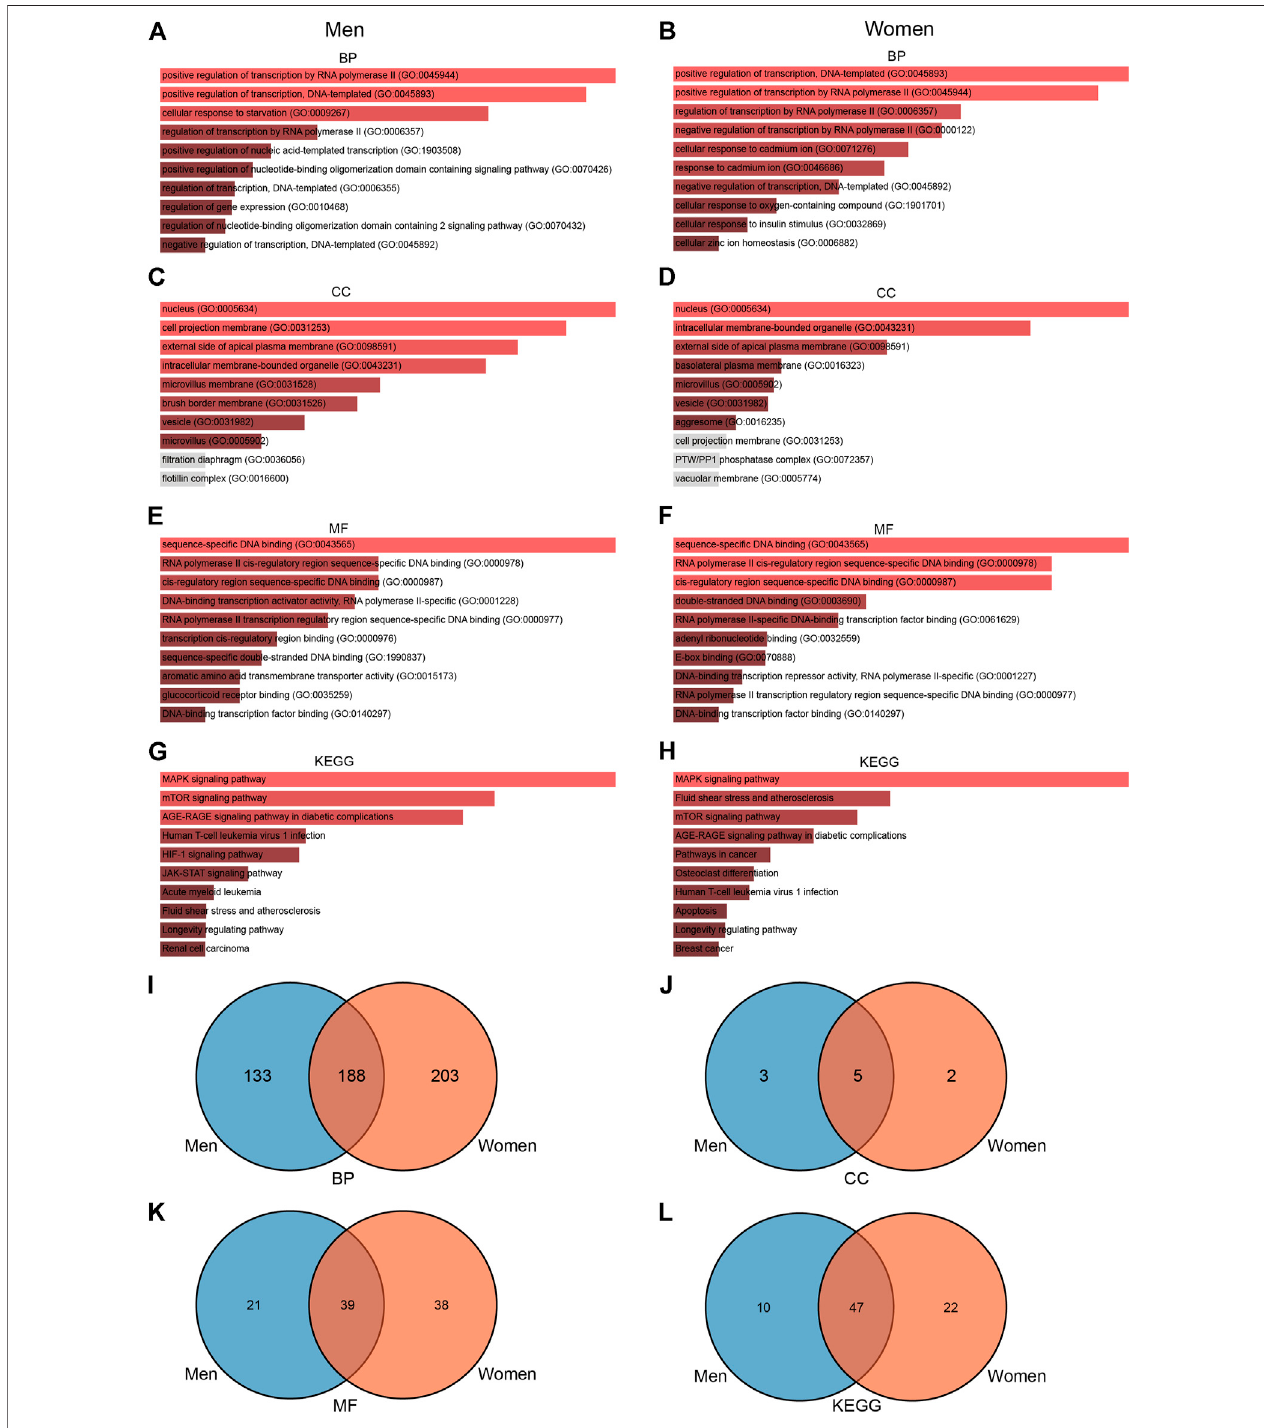
FIGURE 4 | GO and KEGG enrichment analyses of DEGs in men and women. (A) BP enrichment analyses of differentially expressed genes in men. (B) BP enrichment analyses of differentially expressed genes in women. (C) CC enrichment analyses of differentially expressed genes in men. (D) CC enrichment analyses of differentially expressed genes in women. (E) MF enrichment analyses of differentially expressed genes in men. (F) MF enrichment analyses of differentially expressed genes in women. (G) KEGG enrichment analyses of differentially expressed genes in men. (H) KEGG enrichment analyses of differentially expressed genes in women. (I) Venn diagram showing the overlap of BP pathways between men and women. (J) Venn diagram showing the overlap of CC pathways between men and women. (K) VenndiagramshowingtheoverlapofMFpathwaysbetweenmenandwomen. (L) VenndiagramshowingtheoverlapofKEGGpathwaysbetweenmenand women. GO, Gene Ontology; BP, biological process; CC, cellular component; MF, molecular function; KEGG, Kyoto Encyclopedia of Genes and Genomes; TF, transcriptional factor.